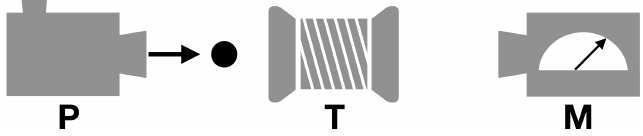
Figure 5: The paradigmatic laboratory situation that can be used to motivate the mathematical framework of GPTs: Preparation P , transformation T , and measurement M